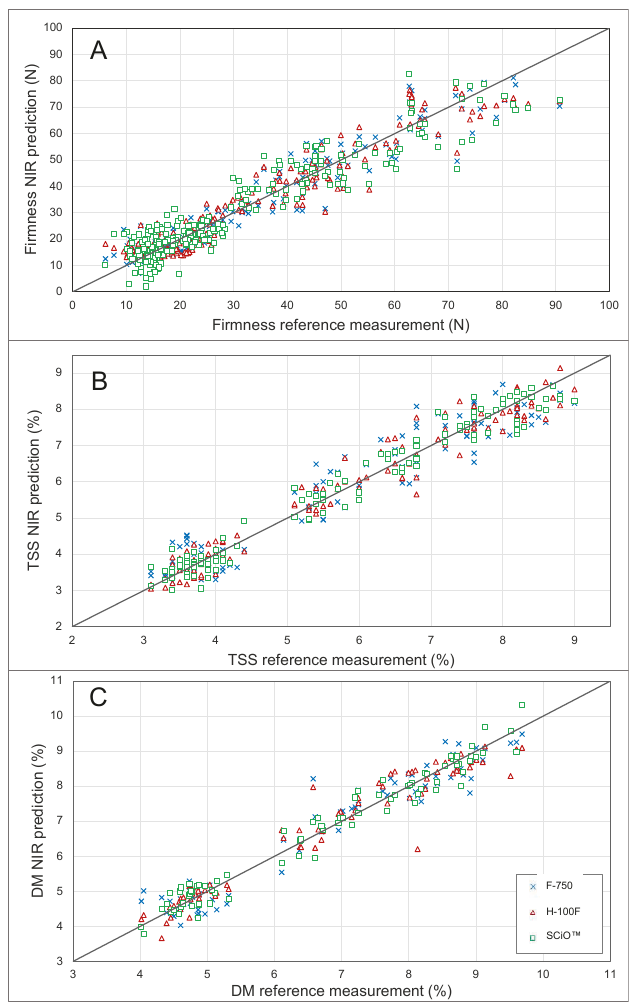
Fig. 3: Correlation between measured and predicted firmness (A), TSS (B), and DM (C) of cross validated models built with The Unscrambler ® of all three food-scanners used in this study. The black line symbol- izes the line of best